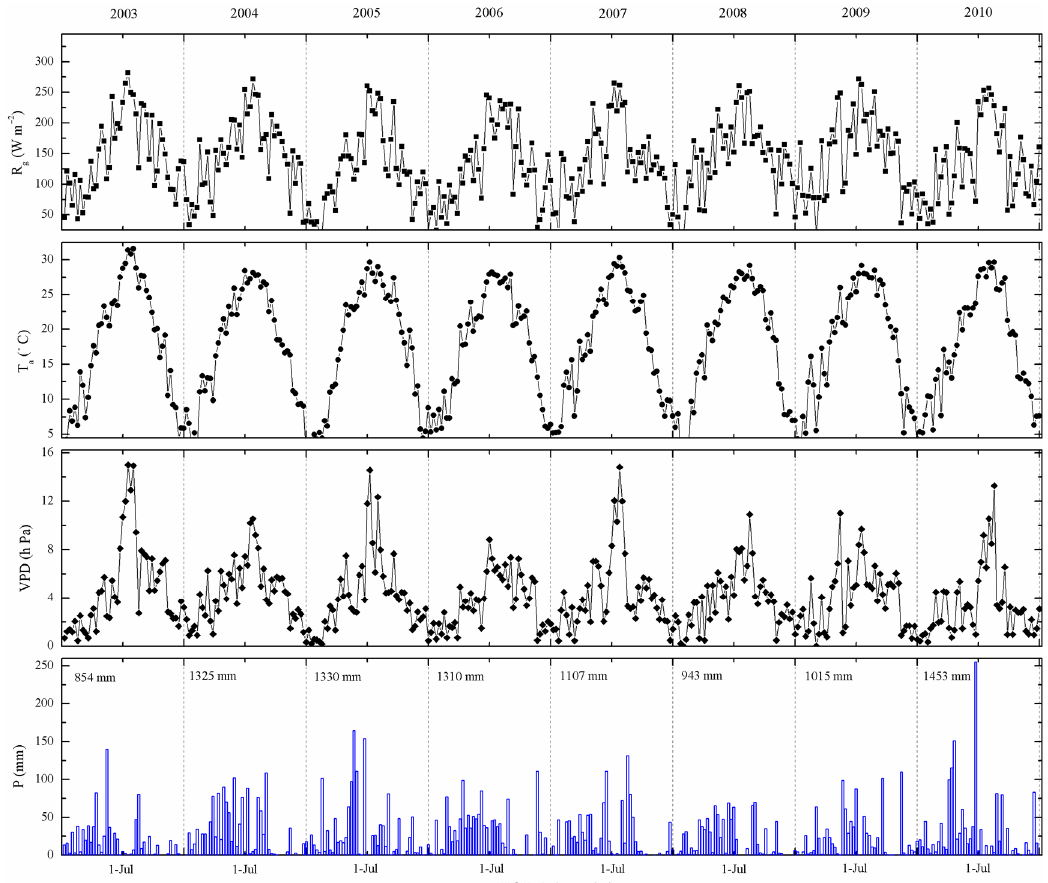
Figure 2. Site-level GPP observations at the two subtropical forest flux sites (QYZ and DHS) for 8- day periods from 2003 to 2010, respectively. For x -axis, the data refer to week of year (WOY) ranging from 1 to 46.